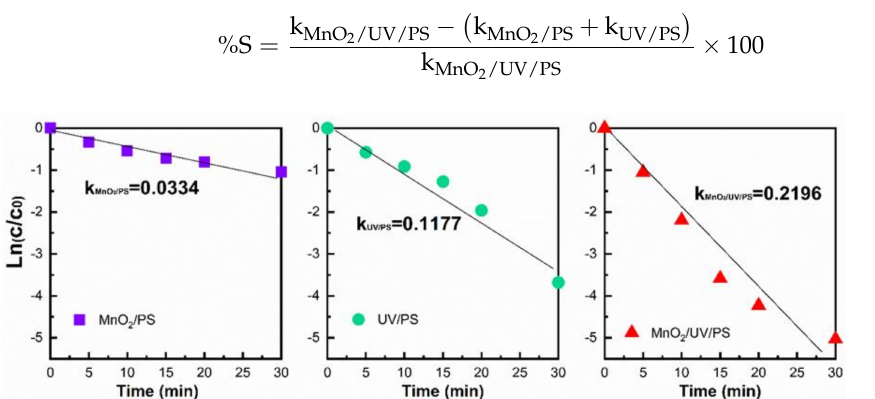
Figure 3. BPA degradation using MnO 2 /PS, UV/PS, and MnO 2 /UV/PS processes over 30 min. k = rate constant of pseudo-first-order kinetics. Conditions at t = 0 min: [BPA] = 30 mg/L, [PS] = 1 mM, [MnO 2 ] = 0.25 g/L, pH =